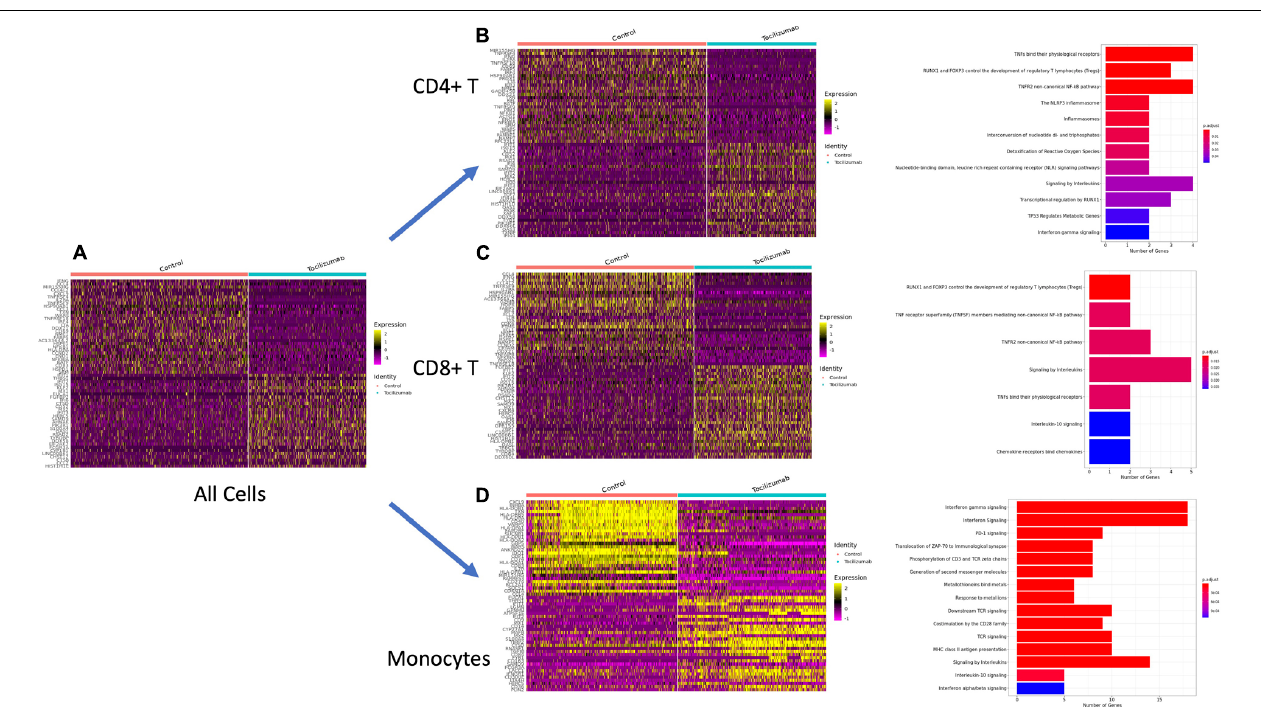
FIGURE 3 | Differential expression testing and pathway analysis of all cells, CD4 + T cells, CD8 + T cells, and monocytes. (A) Heatmap of top 30 genes with highest log-fold changes in all control and Tocilizumab-treated cells. (B) Heatmap of top 30 genes with highest log-fold changes in all CD4 + T control and Tocilizumab-treated cells, with corresponding PA of top 10% most highly differentially expressed genes (based on log 2 -fold change) in control vs. Tocilizumab cells. (C) Heatmap of top 30 genes with highest log-fold changes in all CD8 + T control and Tocilizumab-treated cells, with corresponding PA of top 10% most highly differentially expressed genes (based on log 2 -fold change) in control vs. Tocilizumab cells. (D) Heatmap of top 30 genes with highest log-fold changes in all control and Tocilizumab-treated monocytes, with corresponding PA of top 10% most highly differentially expressed genes (based on log 2 -fold change) in control vs. Tocilizumab cells. Gene expression level represented by color gradient ranging from purple (low expression) to yellow (high expression). PA figure x-axis represents the number of genes from each pathway that was present in the gene list. Adjusted p -values for pathway enrichment are represented as a color gradient with larger p -values colored blue and smaller p -values colored